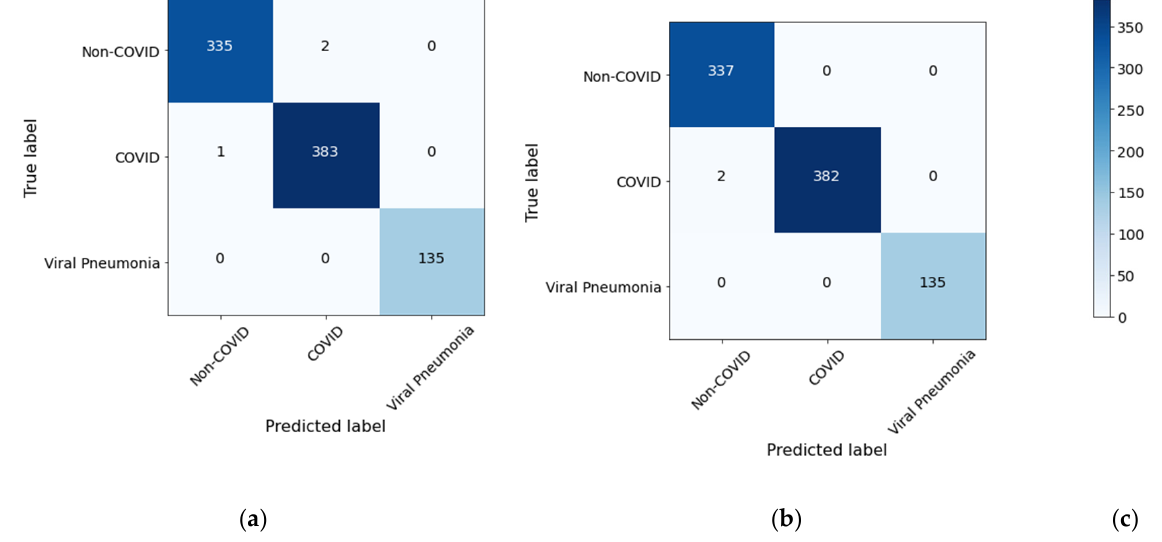
Figure 14. Confusion Matrix for ( a ) Average Ensemble CNN Model, ( b ) Majority Ensemble CNN Model. ( c ) Label.